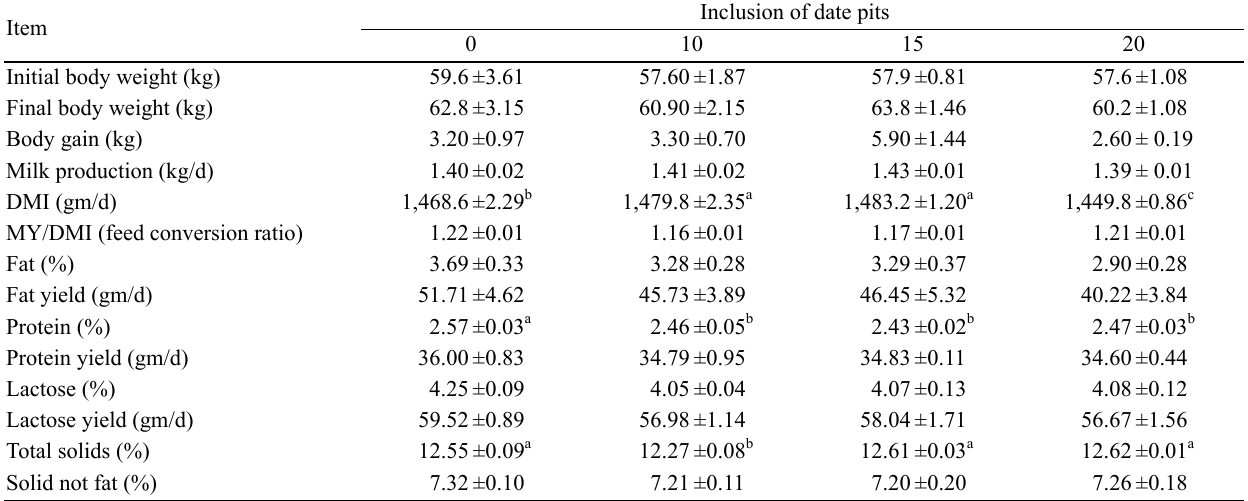
Table 3. Dry matter intake, live body weight and daily milk production and composition of Ardi lactating goats fed diets